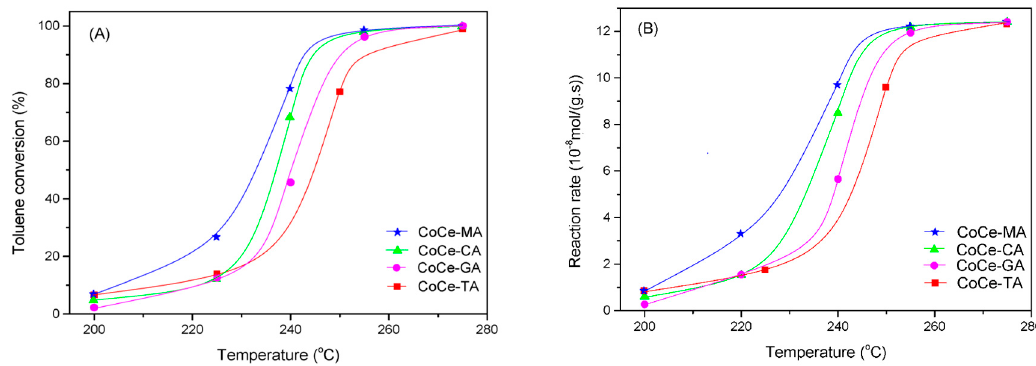
Figure 7. Toluene conversion ( A ); and reaction rate ( B ) as a function of reaction temperature over the CoCe-X catalysts. Reaction conditions: 500 ppm toluene, balanced dry air, total flow rate: 100 mL / min, 300 mg catalyst, GHSV = 20,000 mL / (g · h).